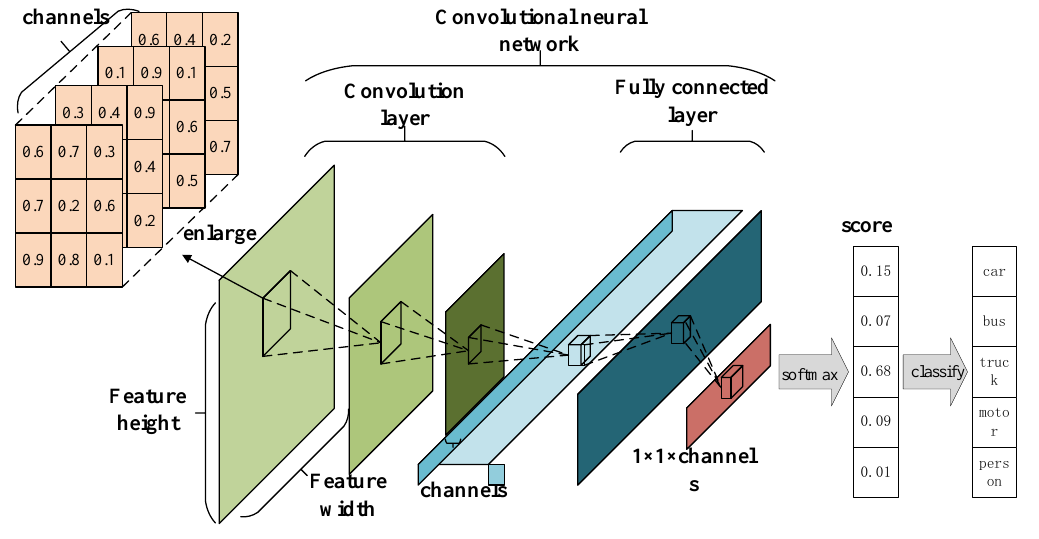
Figure 1. Diagram of the vehicle-type detection method based on compressed sensing (CS) and deep